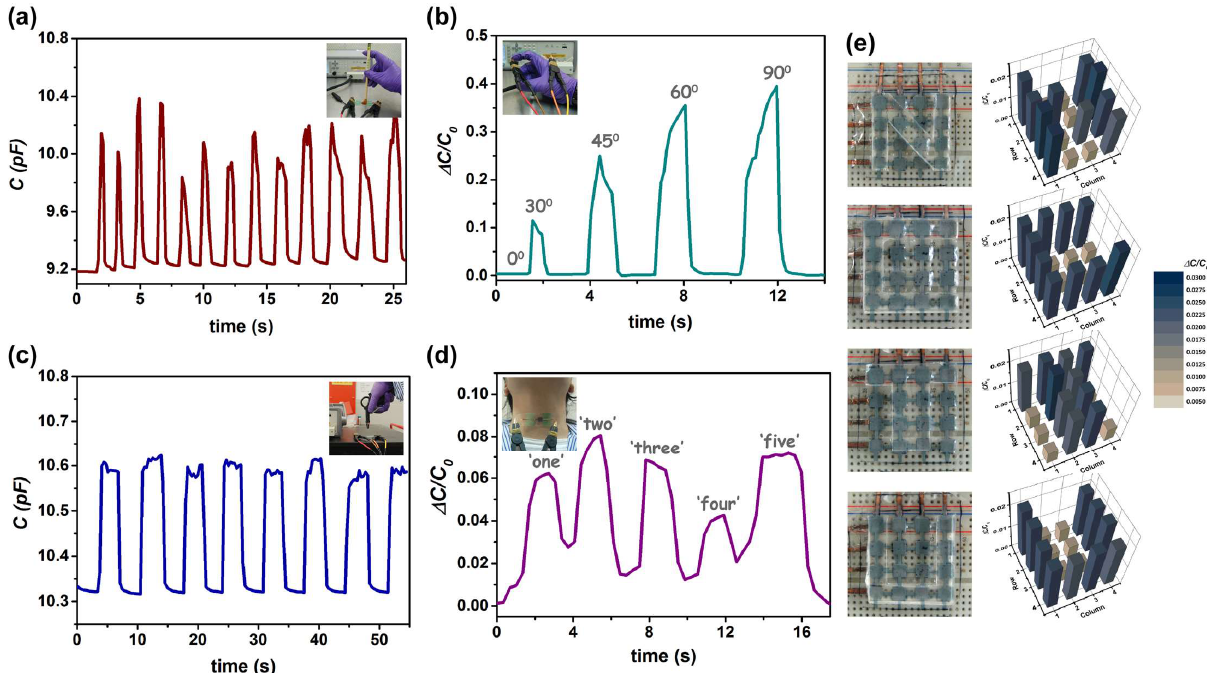
Figure 5. Real-time capacitance variations of the sensor in response to ( a ) calligraphy writing, ( b ) index finger straightening and bending, ( c ) air streaming, and ( d ) vocal speaking. ( e ) Photographs